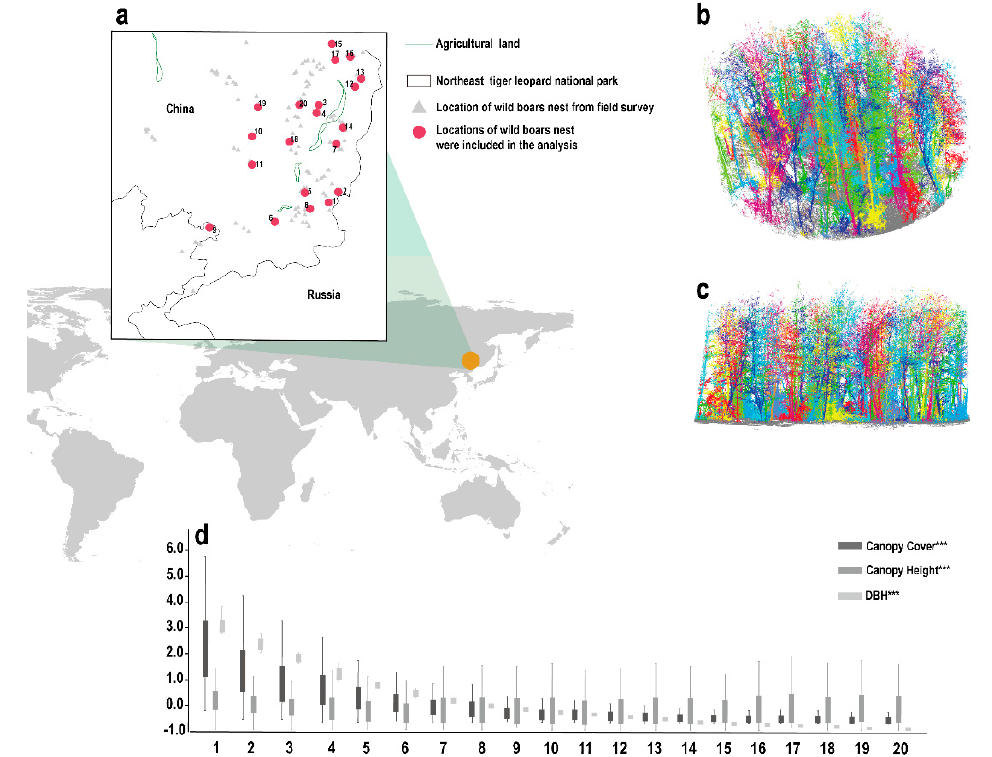
Figure 1. Study system and experimental design. ( a ) Study area. The type of land cover in the study area consisted mainly of Taiga Forest. The 241 gray triangles represent the locations of boar nests obtained during our field survey, and the 20 red circles represent the locations of boar nests used to collect point cloud data in this study. ( b , c ) Sample internal point cloud data display. Point cloud data from the sample of 2021-05-19-09-47-40. ( b ) Top view of point cloud data. ( c ) Flat view of point cloud data. ( d ) The purpose of our study was to find a more general rule, which required that the environmental conditions of 20 samples were different. We used three indicators—canopy height, diameter at breast height, and canopy cover—to represent the environmental conditions. The Kruskal–Wallis test shows that the environmental conditions of the 20 quadrats were significantly different ( p < 0.001 ***). The data are z-scaled to be presented in the same